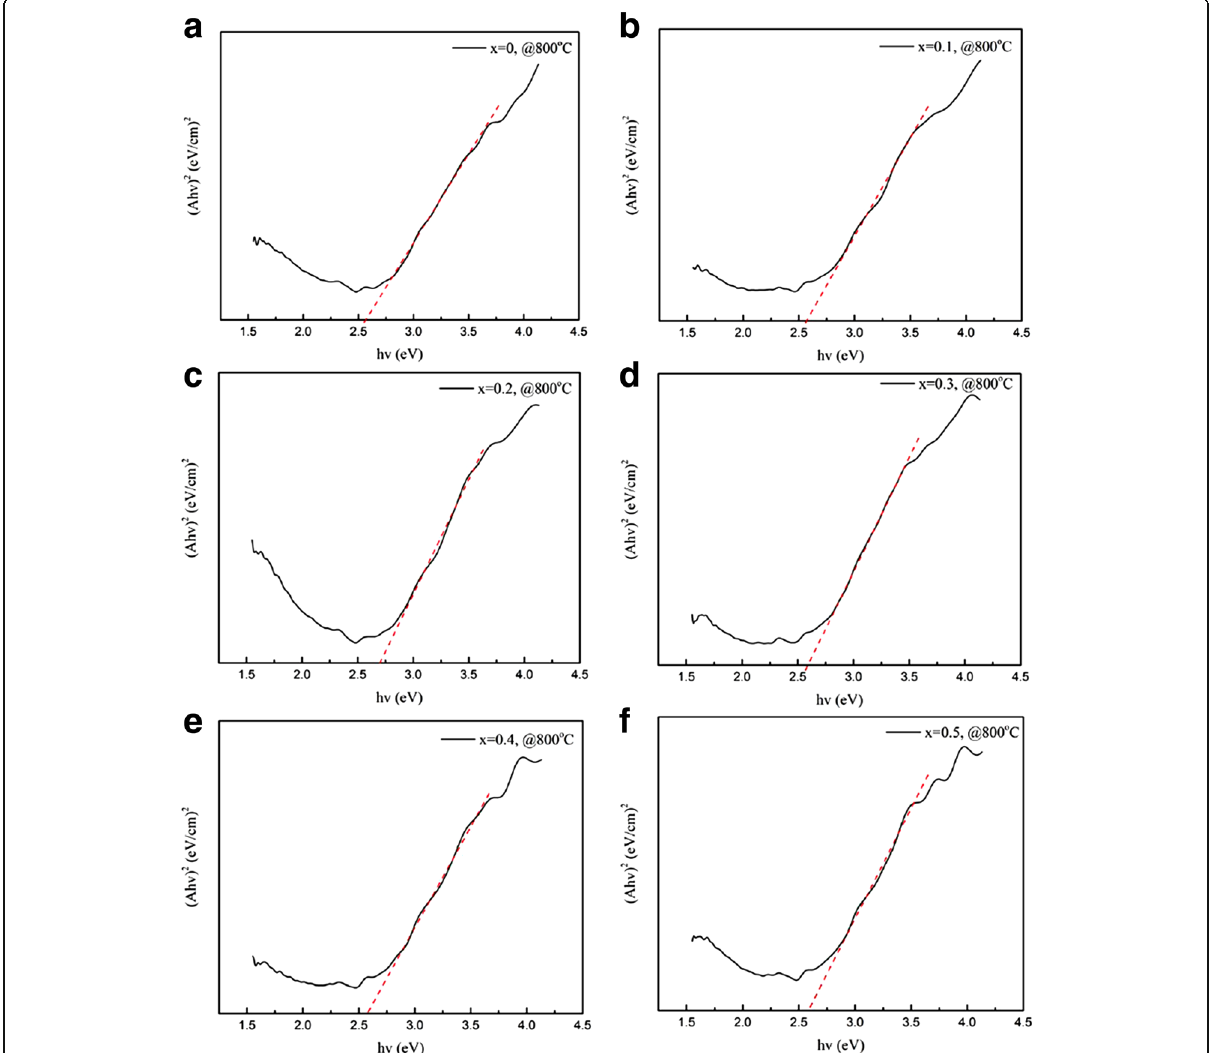
Fig. 8 Variation of ( α h ν ) 2 versus photon energy ( h ν ) for the (La 1 − x Pr x ) 0.67 Ca 0.33 MnO 3 nanoparticles post-annealed at 800 °C with different Pr- doping concentrations. a x = 0.0, b x = 0.1, c x = 0.2, d x = 0.3, e x = 0.4, and f x =